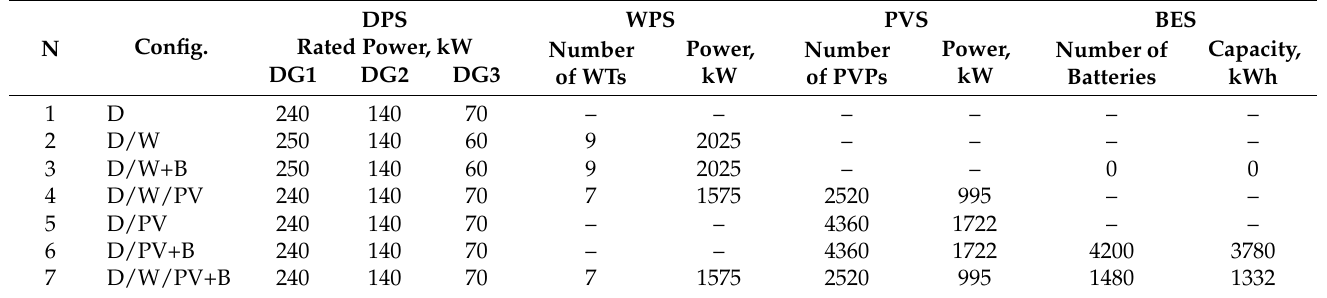
Table 7. Optimal parameters of the considered HES configurations.